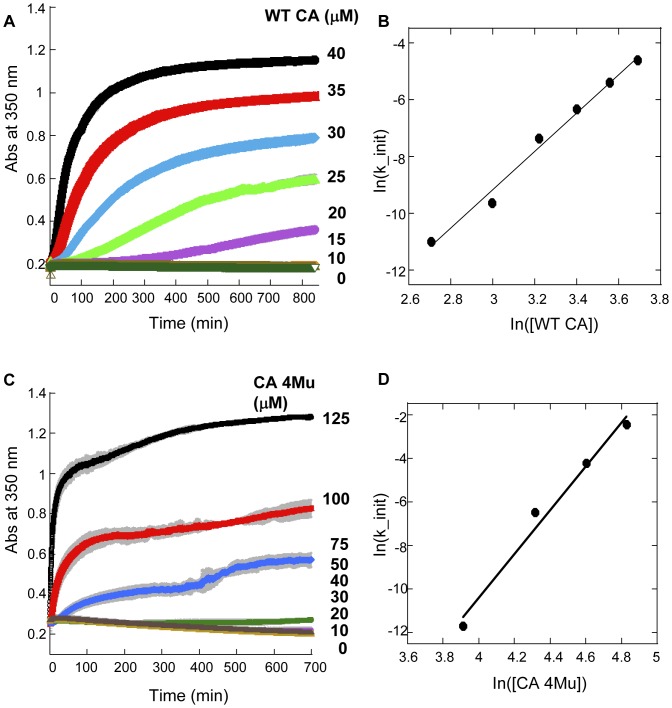
Polymerization kinetics of (A) full-length wild type capsid (WT CA) and (C) mutant capsid [A14C,E45C,W184A,M185A] monomer (CA 4Mu).Assembly reactions were induced by 2-fold dilution of capsid protein into buffer containing 50 mM sodium phosphate (pH 7.5), 4 M NaCl at 25°C. The increase in samples turbidity (absorbance at 350 nm) due to the formation of large oligomeric structures was plotted as a function of time. Final concentration of capsid protein in reaction is depicted on the right side of the kinetic traces. The data points represent an average of three determinations with standard deviation shown as grey bars. The dependence of the initial rate of capsid polymerization is plotted against the concentration of (B) WT CA and (D) CA 4Mu monomer. The initial rate was calculated from the slope of the linear phase of the polymerization curve.